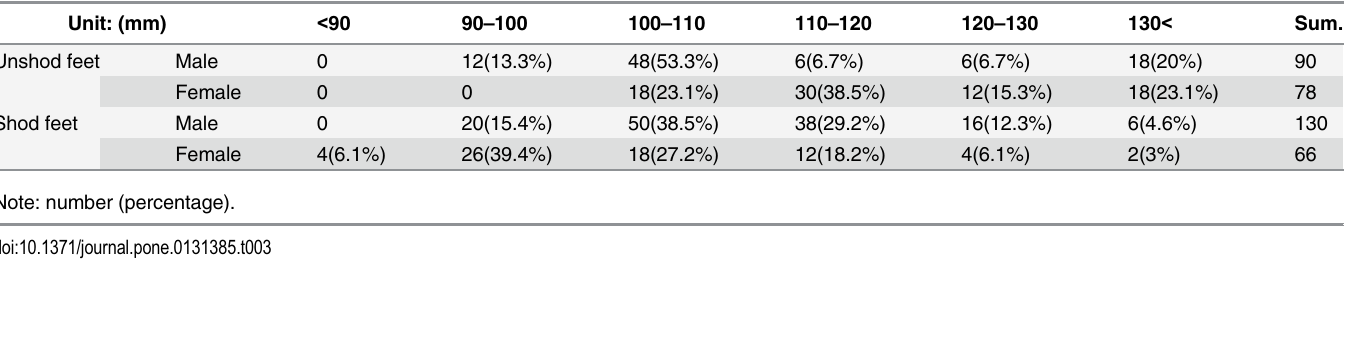
there is a statistically significant difference in the length and width between females with unshod and shod feet with p = 0.001( < 0.01). However, the difference in length and width between males with unshod and shod feet was not significant.